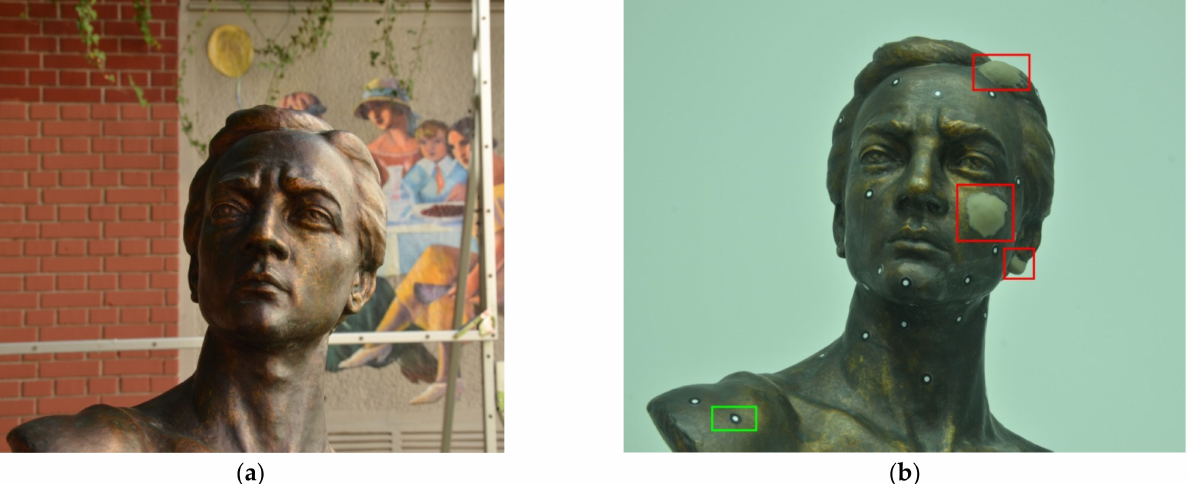
Figure 1. Sculpture that is 3D digitized: ( a ) without built-in error; ( b ) with built-in error (marked with red squares) and reference points for 3D scanner (marked with a green